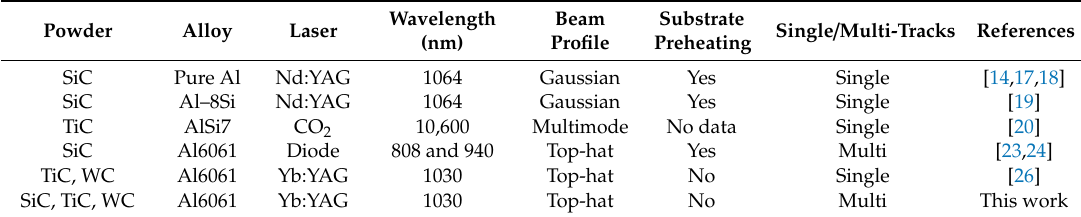
Table 1. Literature data on laser dispersing of carbide powders in Al-based